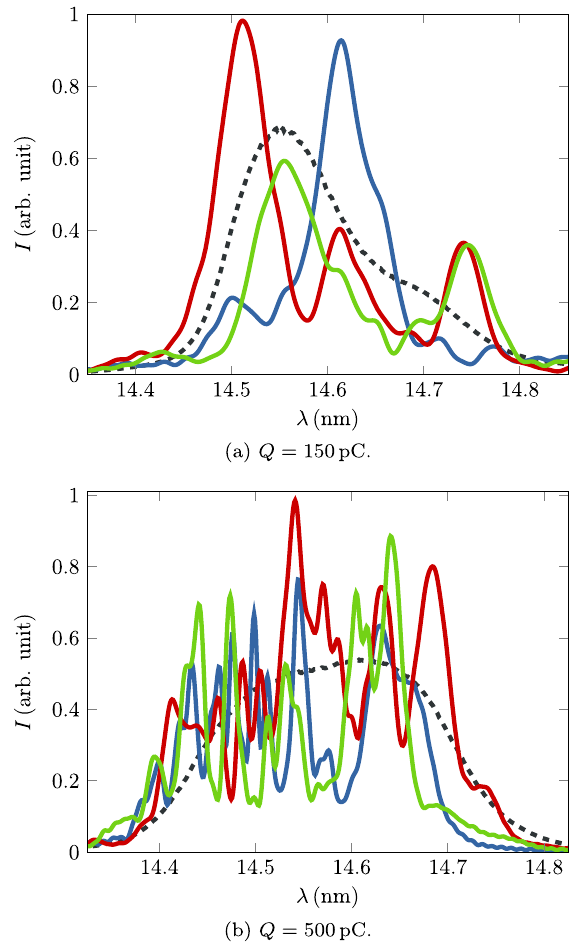
FIG. 8. Single-shot (red, green, and blue solid lines) and mean (dashed black lines) spectra of soft x-ray pulses measured at the end of the exponential gain regime using the SXR spectrometer for the settings with (a) 150 pC and (b) 500 pC. The mean spectra represent an average over (cid:7) 2500 single